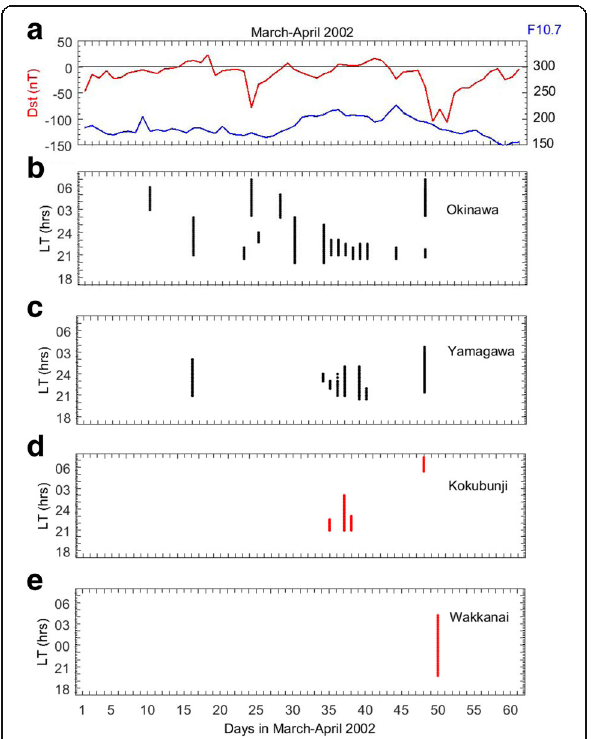
Fig. 3 Statistics of occurrence, onset time and duration of spread-F at b Okinawa, c Yamagawa, d Kokubunji and e Wakkanai in March to April 2003; black bars indicate range type spread-F, and red bars indicate frequency type spread-F. a Daily mean magnetic and solar activity indices (Dst and